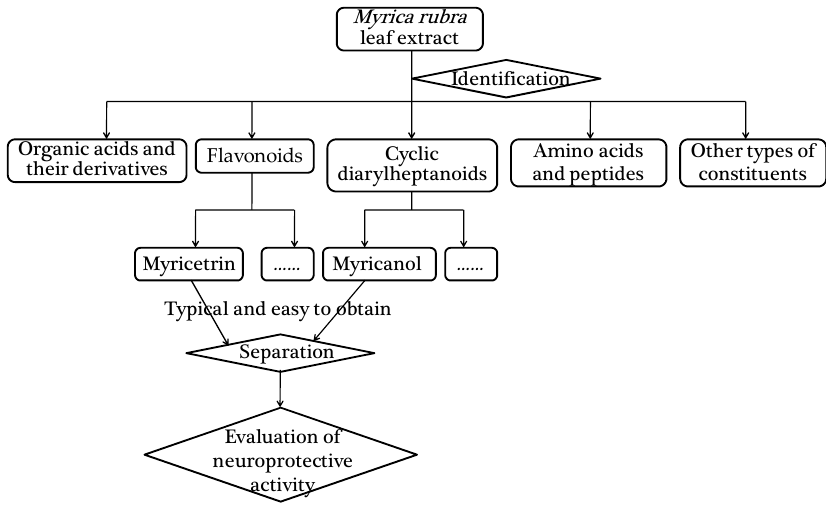
Figure 1. The schematic diagram of the proposed approach.